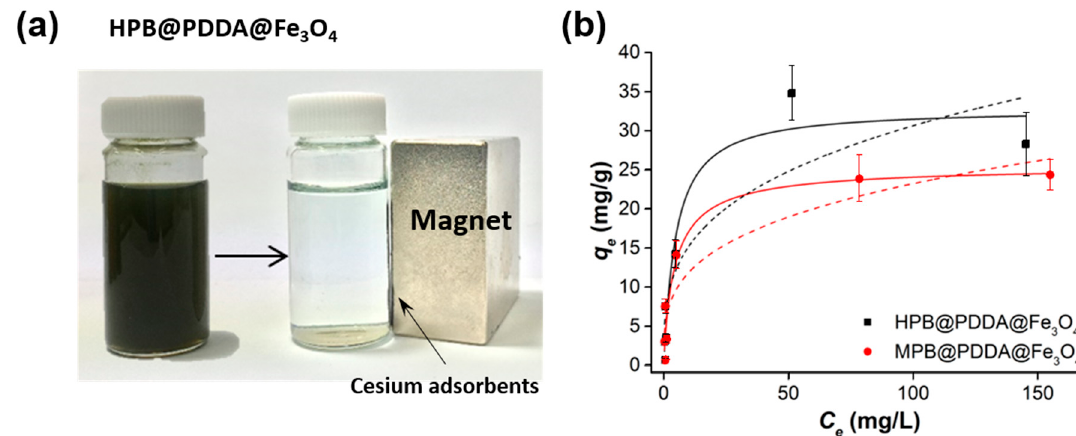
adsorption; ( b ) nonlinear Langmuir (solid lines) and Freundlich (dotted lines) isotherm